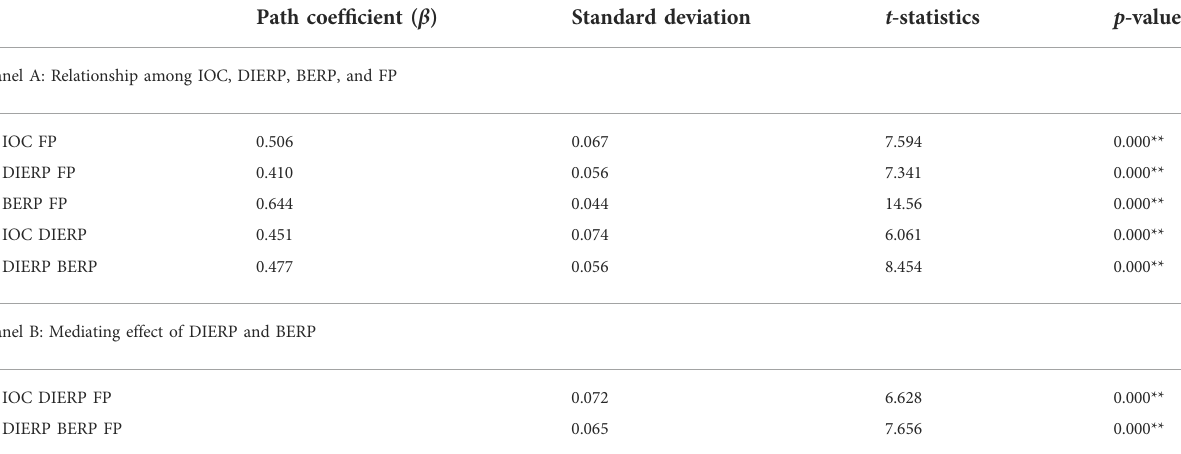
TABLE7RelationshipamongIOC,DIERP,BERP,andFP,andthemediatingroleofBERPandDIERP:Serviceandnon-manufacturingsectorsubsample.